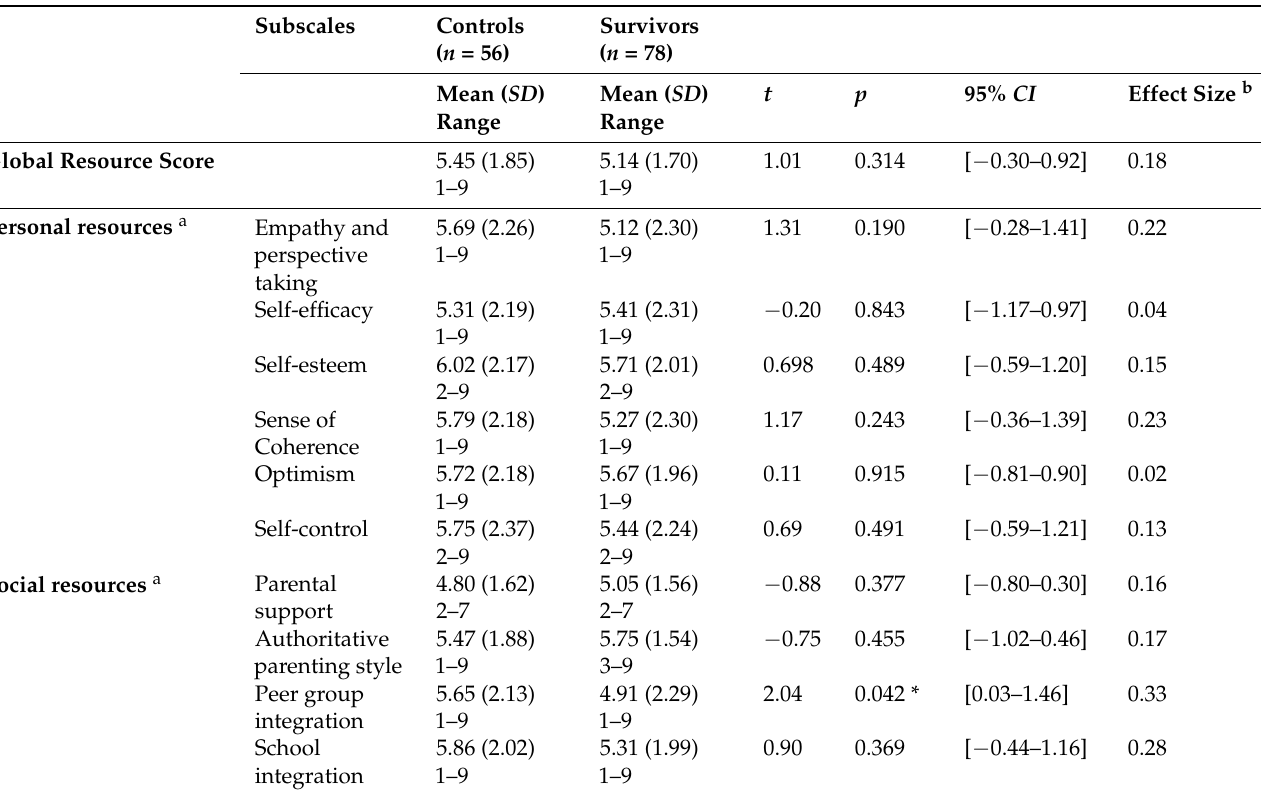
Table 2. Group Means of the Global Resource Score as well as all Subscales of Personal and Social